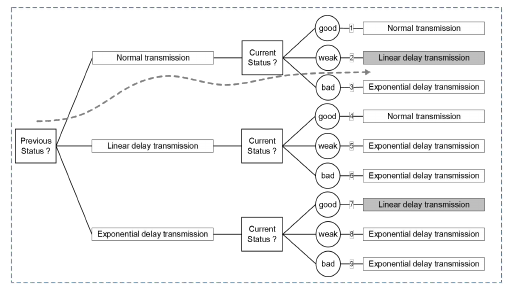
Fig. 6. The Decision Tree of the framework Figure 7. The Decision Tree of the framework